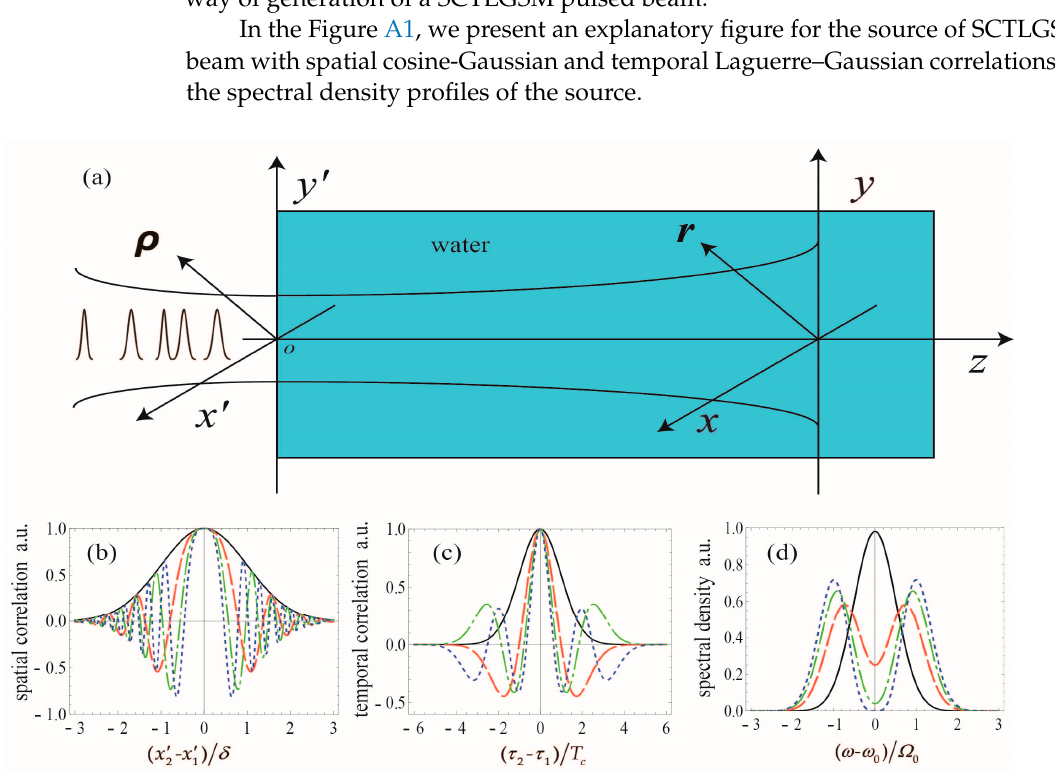
Figure A1. ( a ) Illustrating figure of the SCTLGSM pulsed beam propagating in water. ( b ) Spatial degree of coherence of the pulsed beam source as a function of (𝑥 (cid:2870)(cid:4593) − 𝑥 (cid:2869)(cid:4593) ) 𝛿⁄ . Solid black: m = 0; Dashed red: m = 1; Dash-dotted green: m = 2; Dotted blue: m = 3. ( c ) Temporal degree of coherence of the pulsed beam source as a function of ( τ 2 − τ 1 ) / T c . Solid black: n = 0; Dashed red: n = 1; Dash-dotted green: n = 2; Dotted blue: n = 3. ( d ) Spectral density of the pulsed beam source as a function of ( ω − ω 0 )/ Ω 0 . Solid black: Ω c / Ω 0 =1; Dashed red: Ω c / Ω 0 = 1; Dash-dotted green: Ω c / Ω 0 = 0.5; Dotted blue: Ω c / Ω 0 = 0.1.